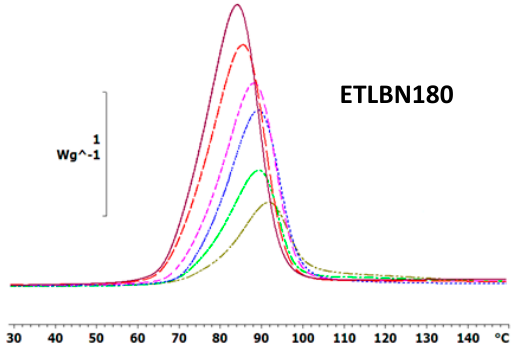
Figure 2. Non-isothermal DSC scans at 5 K / min for ETLBN2- y , ETLBN30- y and ETLBN180- y , in which y refers to the different BN contents given in Table 1: purple, full line, y =0; long dash, red, y =10; short dash, pink, y =30; dash-dot, blue, y =50; dotted, light green, y =60; dash-double dot, dark green, y =70.